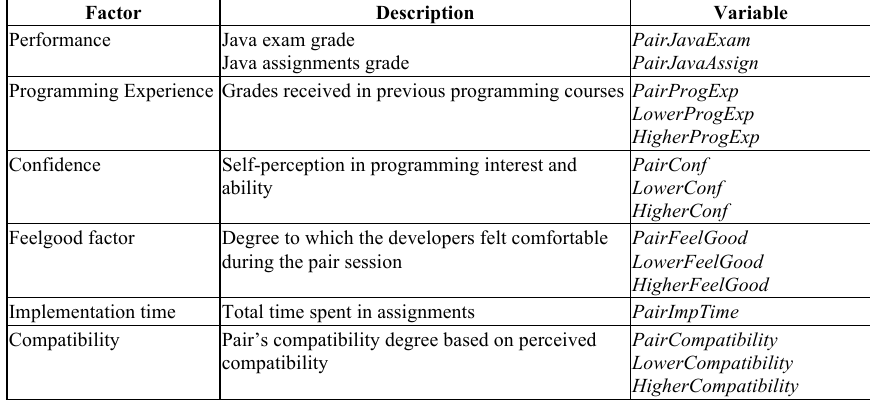
Table 2. Factors and variables of the